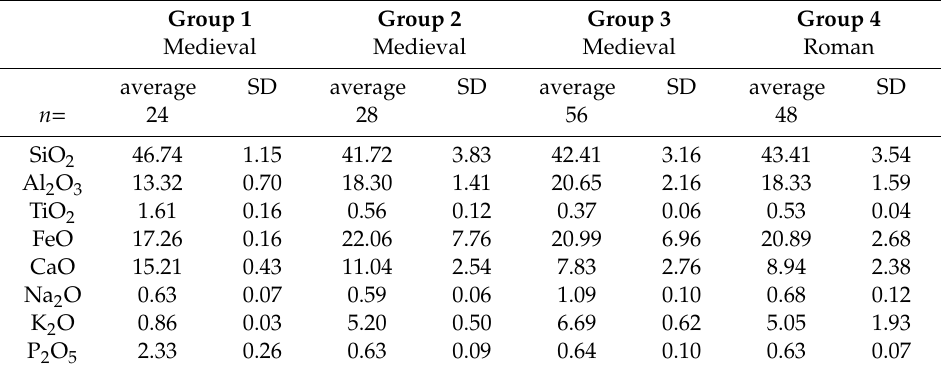
Abbreviations: SD, standard deviation.